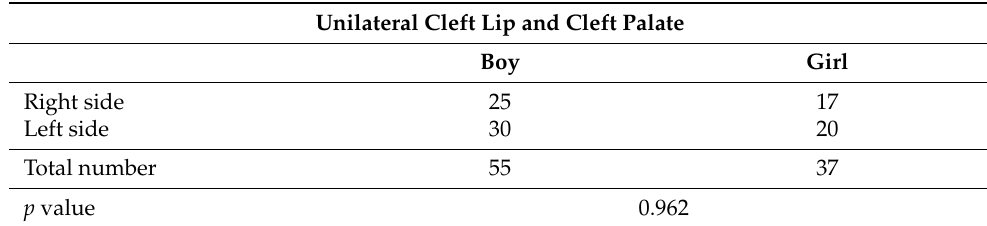
Table 4. Distribution of gender and relationship between gender and the affected side.